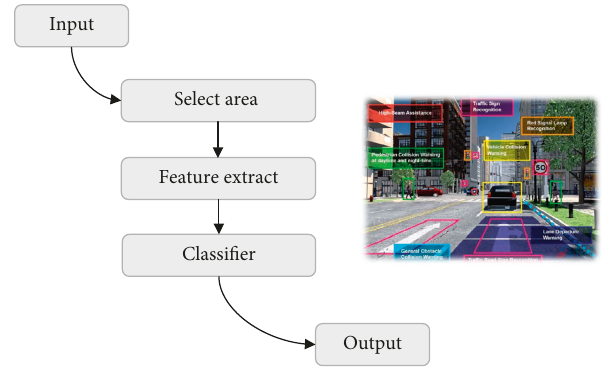
Figure 1: Traditional target detection